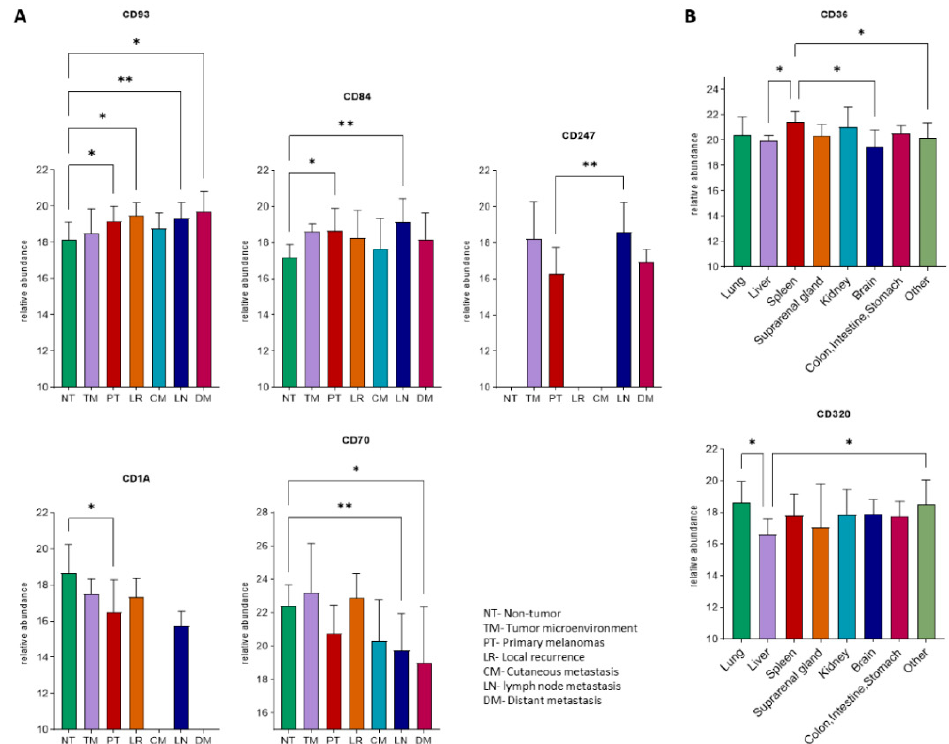
Figure 6. Relative abundance levels of proteins with significant differences between sample origin-based groups in the proteomics cohorts. ( A ) Proteins with significant differences between at least two groups from the prospective cohort. ( B ) Proteins with significant differences between at least two groups from the postmortem cohort. Asterisks represent the level of significance (* p < 0.05; ** p < 0.01) using Analysis of Variance (ANOVA) test adjusted with the Benjamini–Hochberg method and an additional Tukey–Kramer post hoc test for each ANOVA analysis. Table 4. Comparison of copy number changes and mutant allele frequency in matched primary tumors and metastasis pairs.